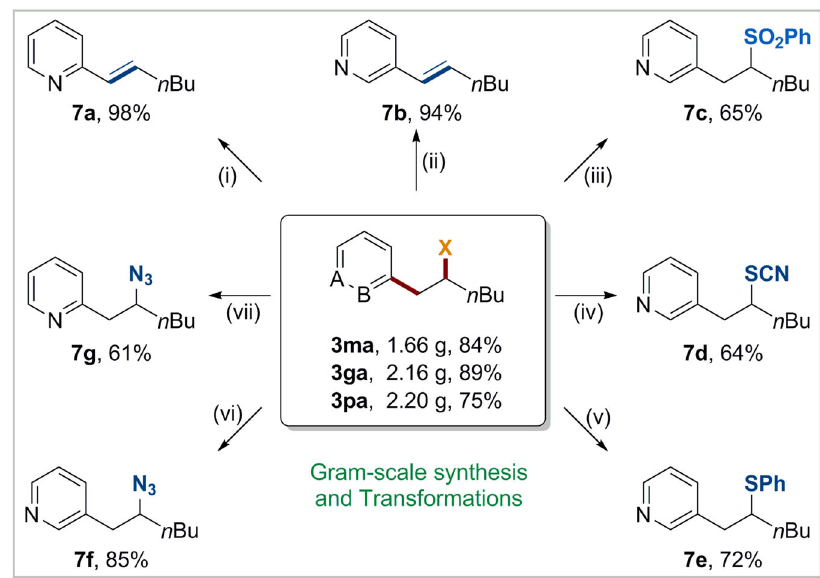
Fig. 6 Synthetic transformations. ( i ) 3ga , K 2 CO 3 , DMF, 80 °C, 6 h. ( ii ) 3pa , K 2 CO 3 , DMF, 80 °C, 6 h. ( iii ) 3pa , NaSO 2 Ph, DMF, 60 °C, 3 h. ( iv ) 3pa , NaSCN, Na 2 CO 3 , MeCN, 40 °C, 3 h. ( v ) 3pa , thiophenol, Na 2 CO 3 , MeCN, 40 °C, 7 h. ( vi ) 3pa , NaN 3 , DMF, 60 °C, 10 h. ( vii ) 3ga , NaN 3 , DMF, 60 °C, 10